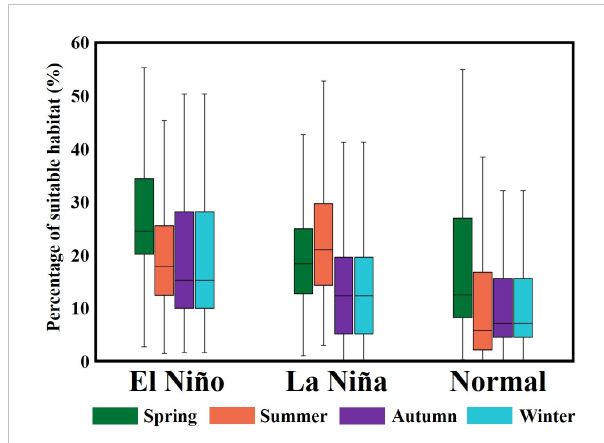
FIGURE 10 Percentage of suitable habitat area for greater amberjack in the Taiwan Strait in each season during ENSO events.